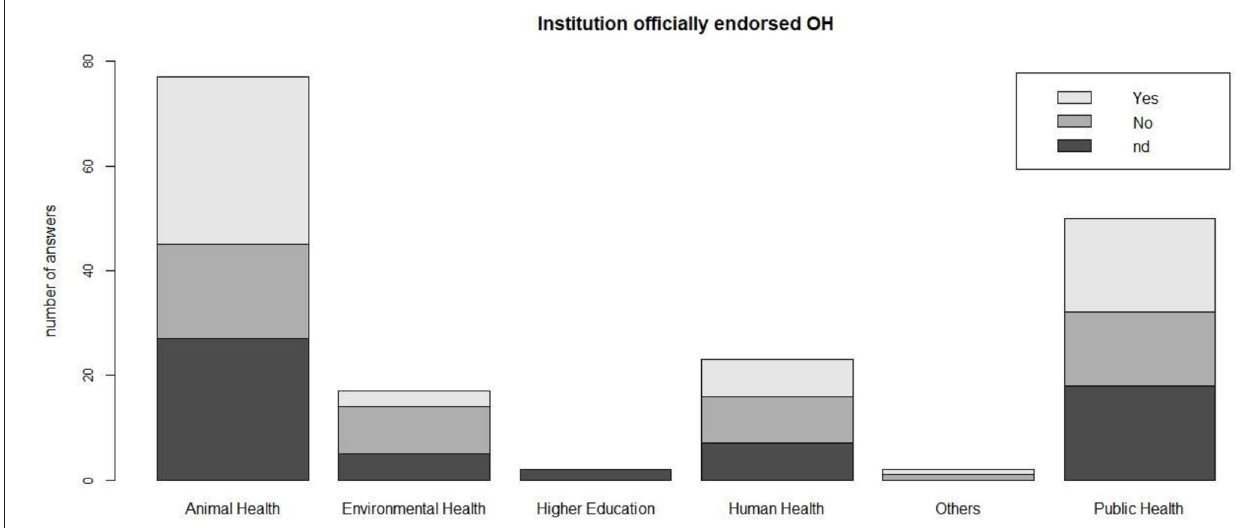
FIGURE 3 | Endorsement of OH initiatives by different types of institutions where respondents are employed.